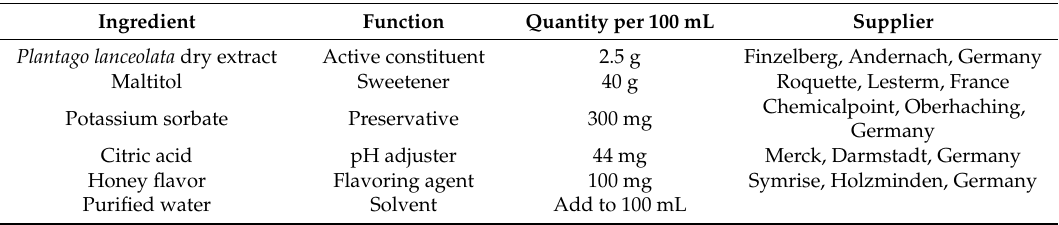
Table 1. Composition of Plantago lanceolata syrup (100 mL).